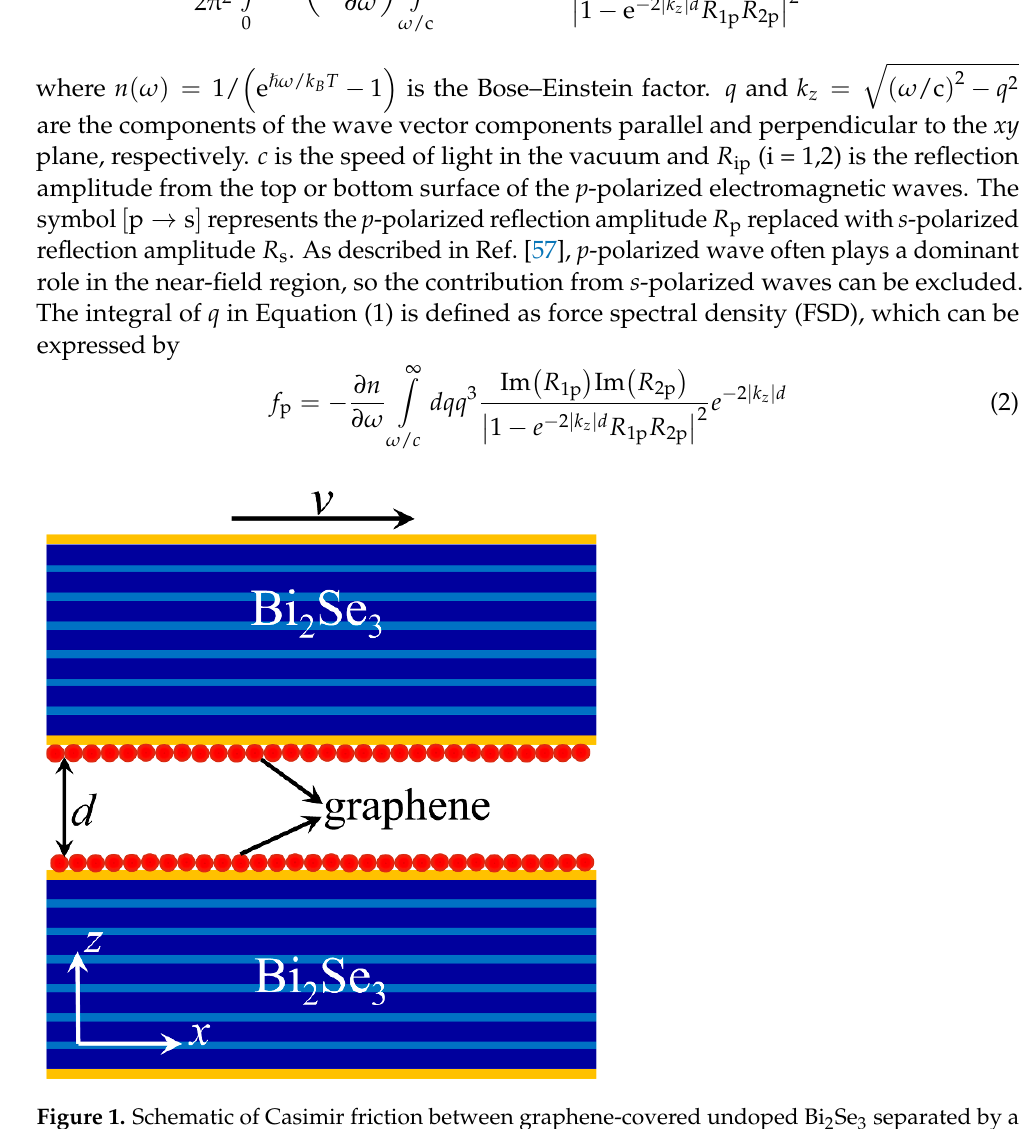
Figure 1. Schematic of Casimir friction between graphene-covered undoped Bi 2 Se 3 separated by a distance d . The layered structure denotes Bi 2 Se 3 and the two thin orange layers at the top and bottom of Bi 2 Se 3 represent the surface states.